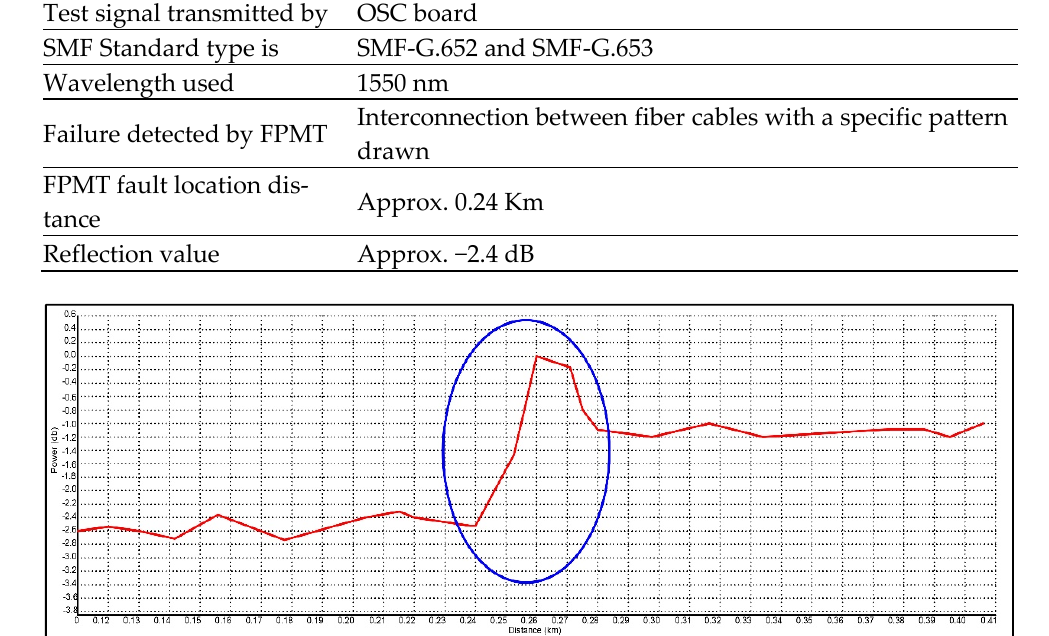
Figure 13. The fiber interconnection event between fiber cables G652 and G653 and the FPMT test signals transmitted by the OSC board.